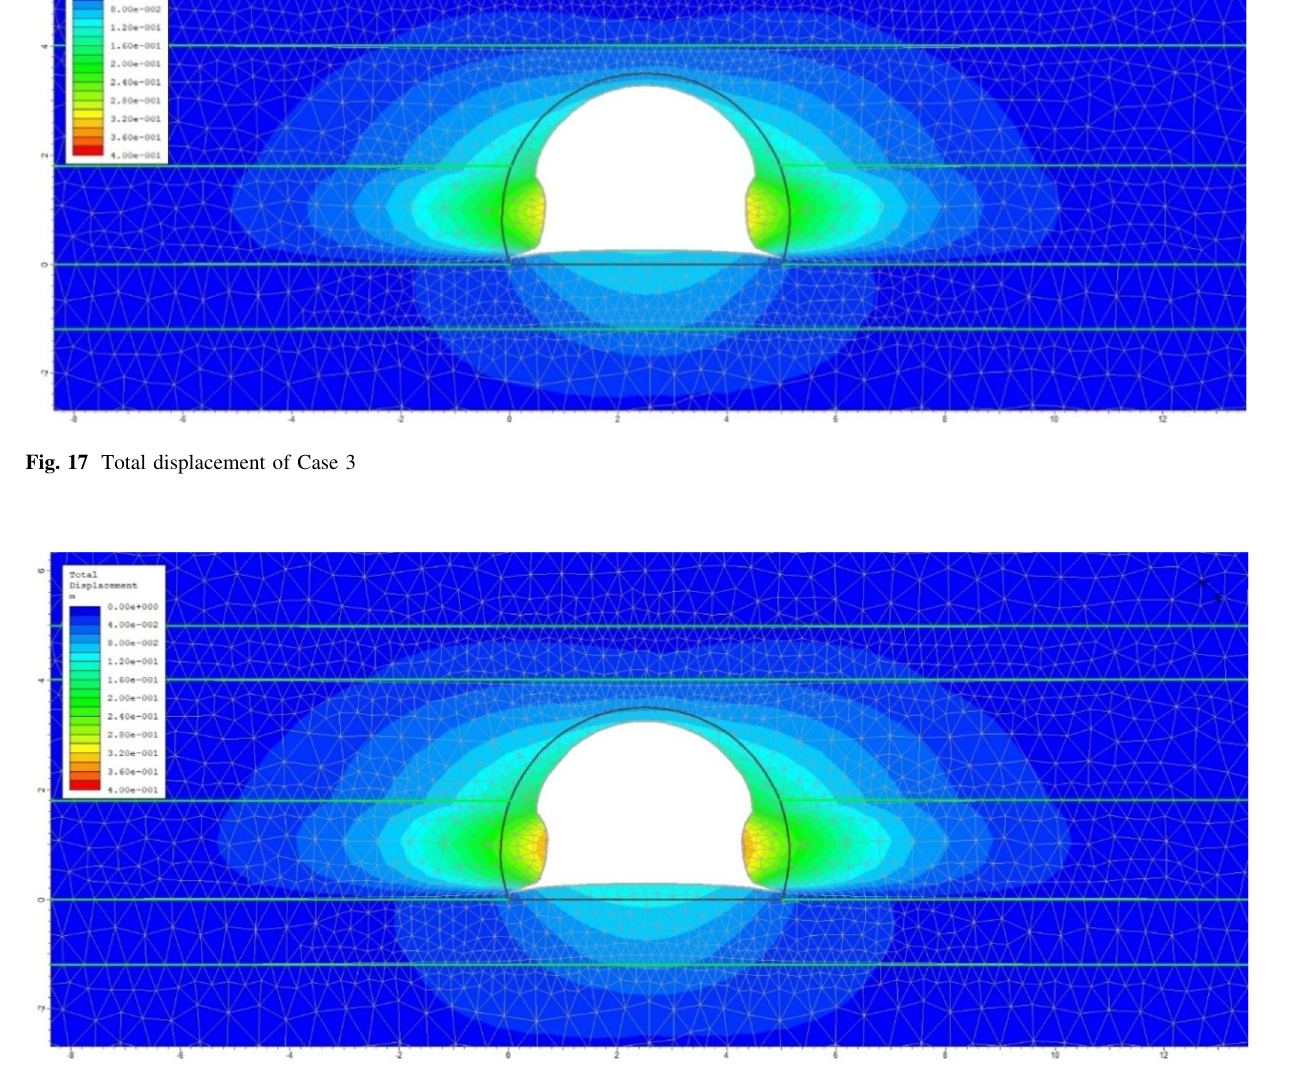
Fig. 18 Total displacement of Case